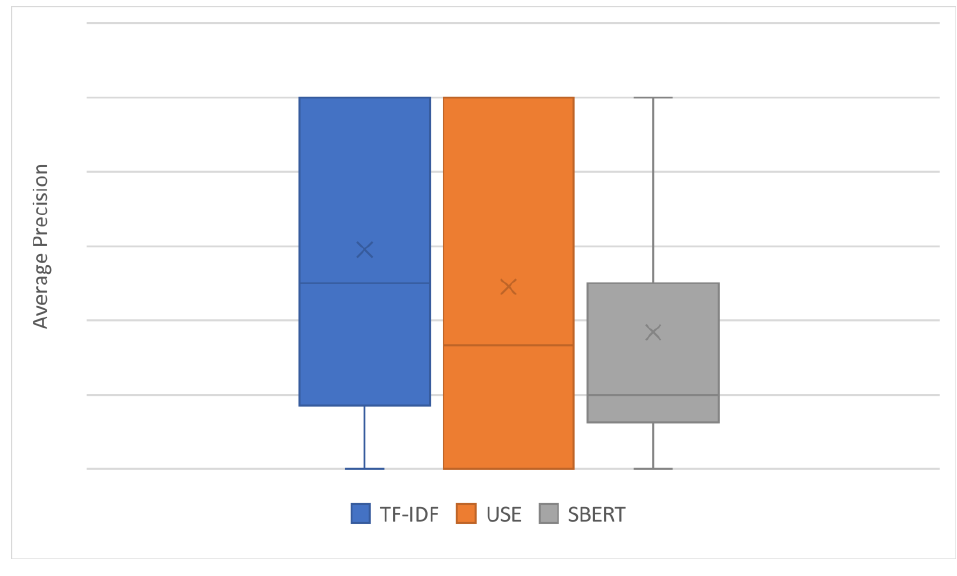
Figure 14. Box plot of average precision.